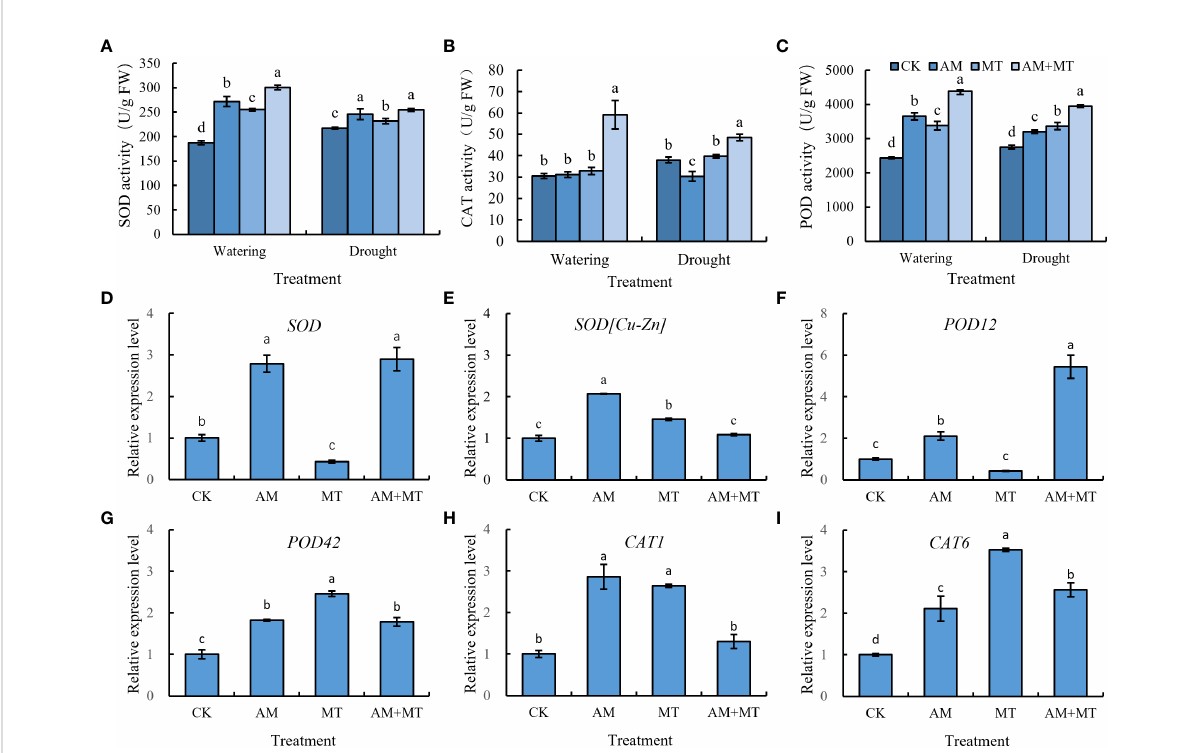
FIGURE 7 Changes of antioxidant activity of SOD (A) , CAT (B) , and POD (C) , and gene expression (D – I) in kiwifruit seedlings under well watering and drought stress. Data are presented as meant ± SD ( n = 3), different letters indicate signi fi cant differences between treatments at p < 0.05 by Tukey ’ s Post Hoc test. Treatments included CK (the control), AM (inoculated with arbuscular mycorrhiza), MT (irrigated with 100 m M melatonin), and AM+MT (treated with melatonin and arbuscular